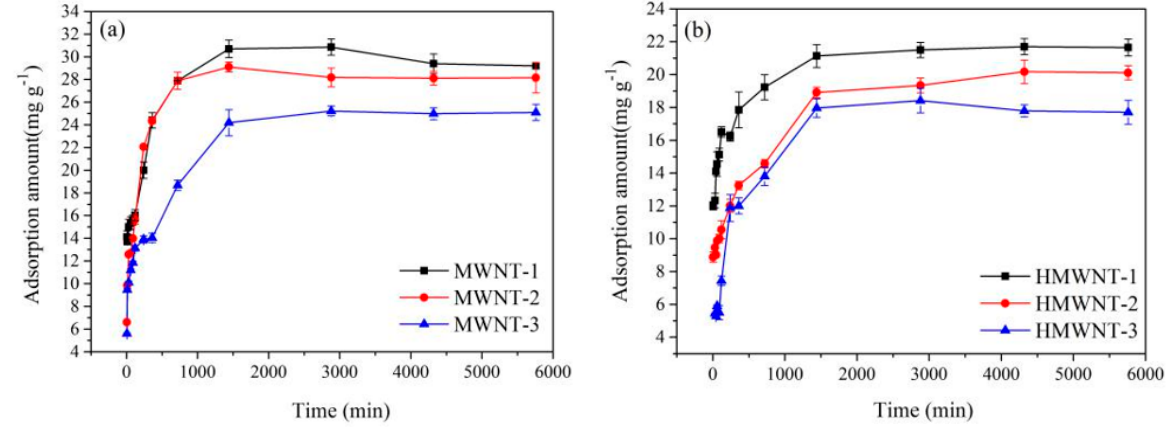
Figure 6. HA adsorption on MWNT ( a ) and HMWNT ( b ) surfaces under different equilibrium times. In order to quantify the time-dependent variation in the HA adsorption on the MWNT and HMWNT surfaces, pseudo-first-order (Equation (3)) (Figure S4) and pseudo-second- order (Equation (4)) (Figure 7) kinetic models were used for fitting the time-de- pendent profiles [37,38]. The adsorption kinetic parameters of HA can be calculated by measuring the adsorption rate of HA on MWNTs and HMWNTs.